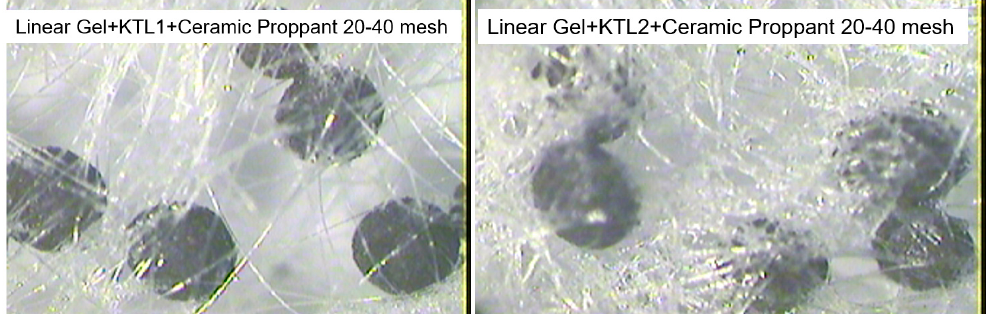
Figure 1. The microstructure of fibers and proppants.